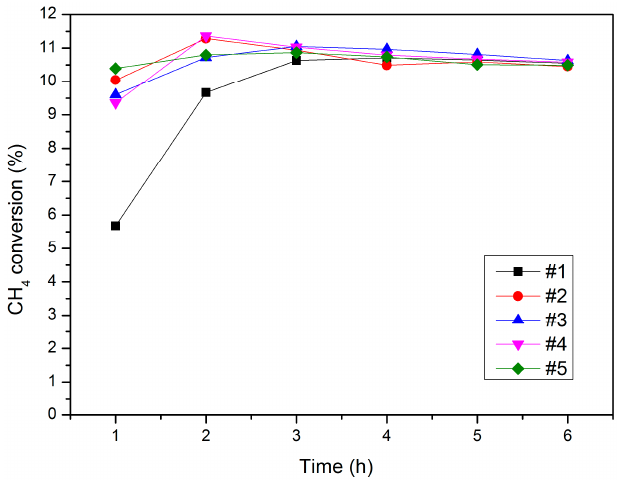
Figure 13. Reusability test of 2Cr3Ru/Al 2 O 3 catalyst during five cycles (#1–#5). Reaction conditions: feed gas O 2 / CH 4 volume ratio = 3 / 5, GHSV = 15,000 h − 1 , and reactor temperature = 475 ◦